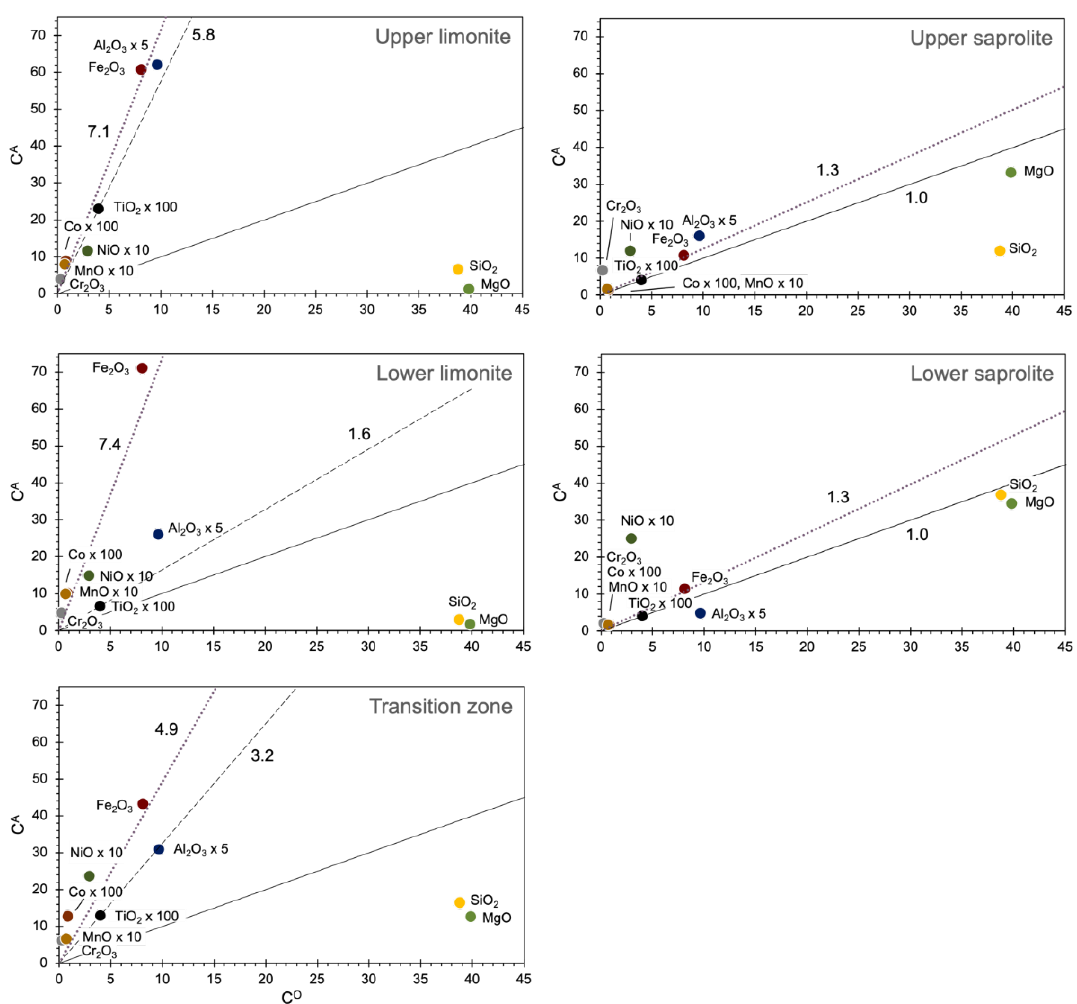
Figure 10. Isocon diagrams for each laterite zone in the outcrop investigated. Altered compositions (C A ) are the average composition of the samples from each zone. The composition of the parent rock (C O ) is the average composition of two peridotite samples collected near the study area (Table 2). Dashed line is the isocon defined by the immobile species Ti and the origin, while dotted line is the best-fit isocon defined by Fe, Ti, and the origin. Solid line represents M O /M A = 1. The numbers are the slope of the isocon or M O /M A . Species plotting along the isocon did not change their mass during transformation, species plotting above the isocon experienced mass gains, whereas species plotting below the isocon experienced mass loss during transformation.